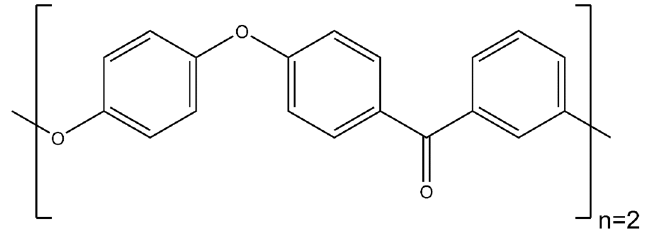
Figure 8. Molecular structure of peek dimer.